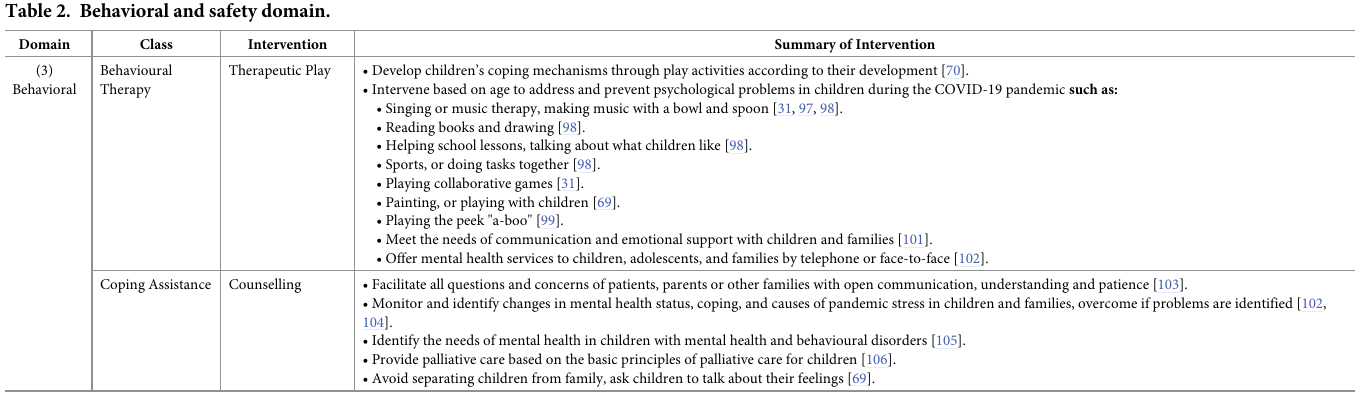
Table 2. Behavioral and safety